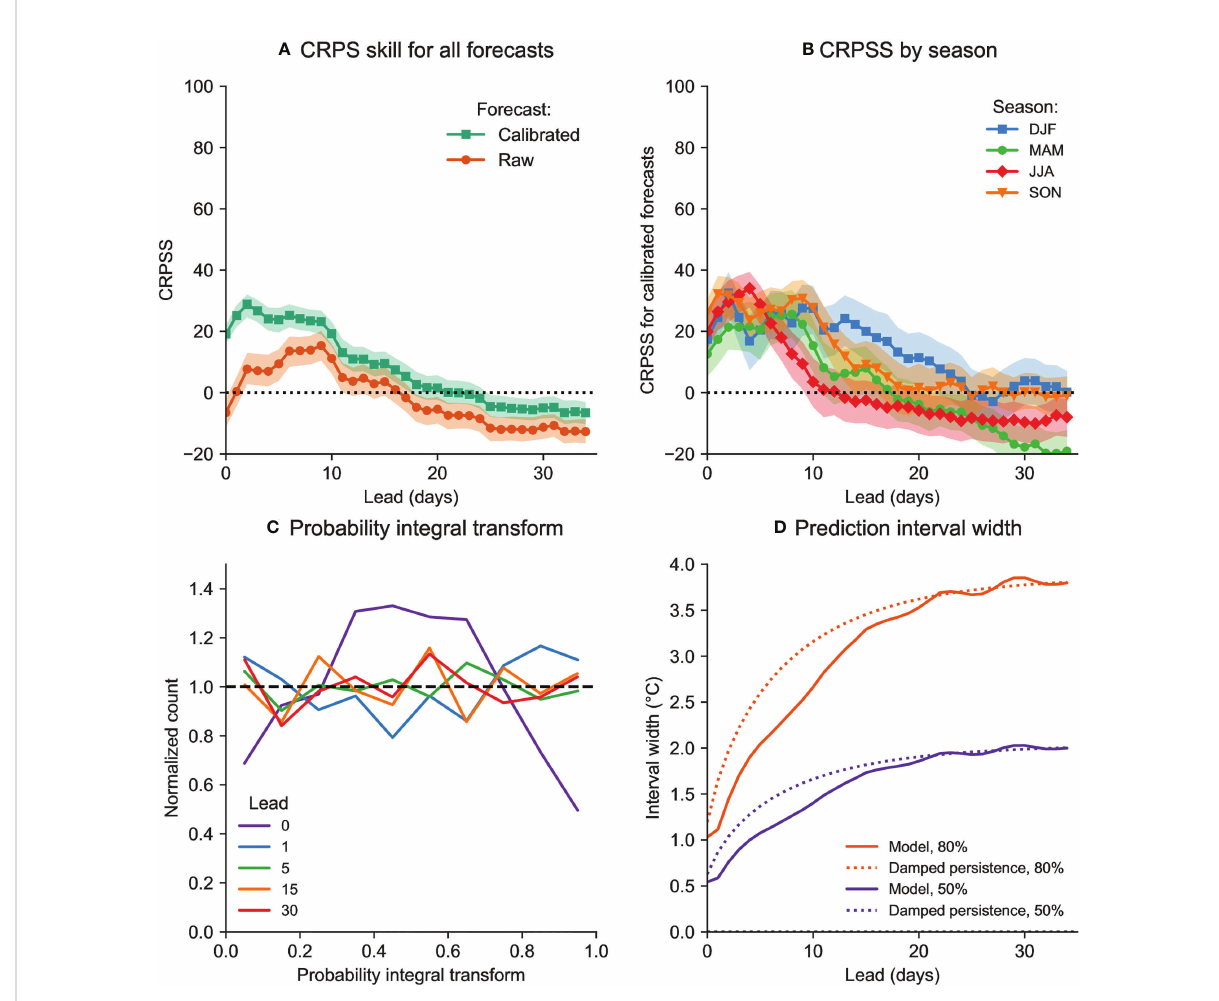
FIGURE 6 Assessment of the probabilistic forecasts. (A) Skill metrics based on the continuous ranked probability score (CRPS) for all forecasts. This fi gure compares the NGR calibrated forecasts (Section 2.3) with probabilistic forecasts where the uncertainty is determined by the raw ensemble. (B) Skill scores for the calibrated forecasts evaluated separately by initialization season. In both panels (A) and (B) , shaded regions are 90% con fi dence intervals. (C) Probability integral transform plots for various forecast lead times. (D) Median widths of the 50 and 80 percent prediction intervals for the calibrated and damped persistence